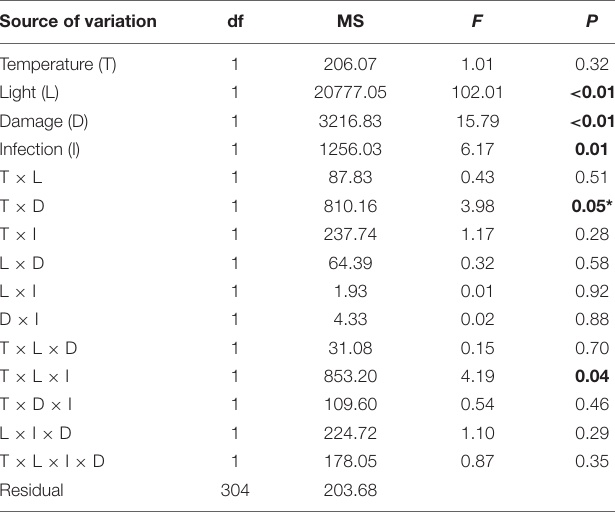
TABLE 3 | Analysis of variance of Zostera marina growth (% growth relative to initial size) under different levels and combinations of temperature (ambient and increased), light (reduced and ambient), tissue damage (damaged and undamaged), and Labyrinthula zosterae infection (non-inoculated and